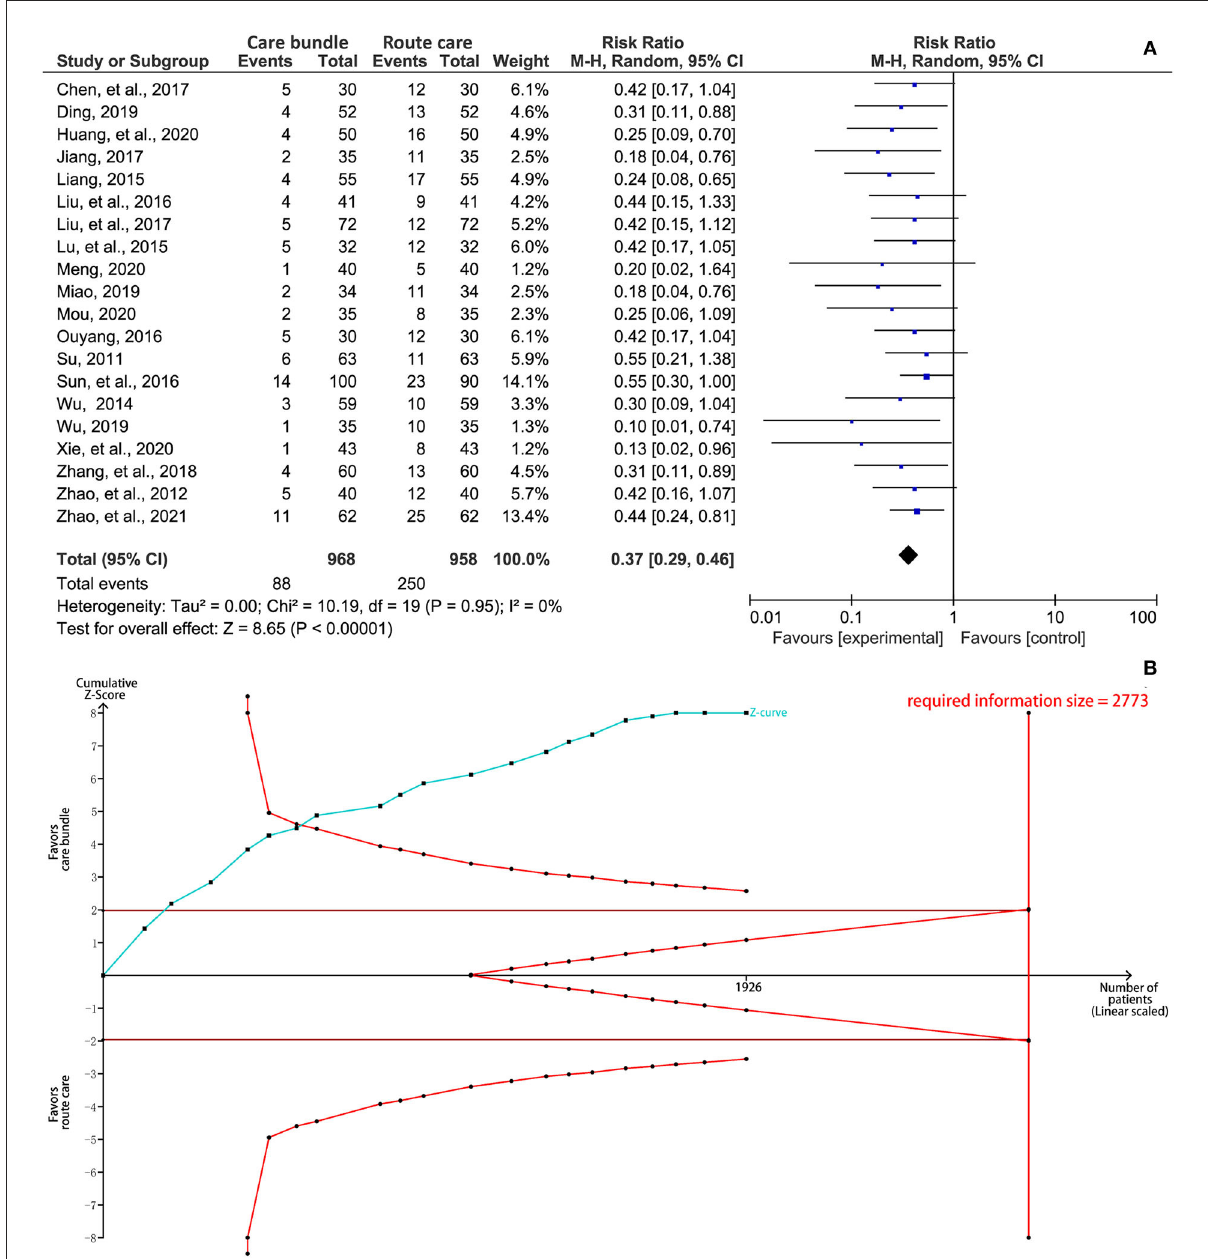
FIGURE3 Synthesis analysis of the incidence of stroke-associated pneumonia. (A) forest plot and (B) results of TSA. CI, confidence interval; TSA, trial sequential analysis.